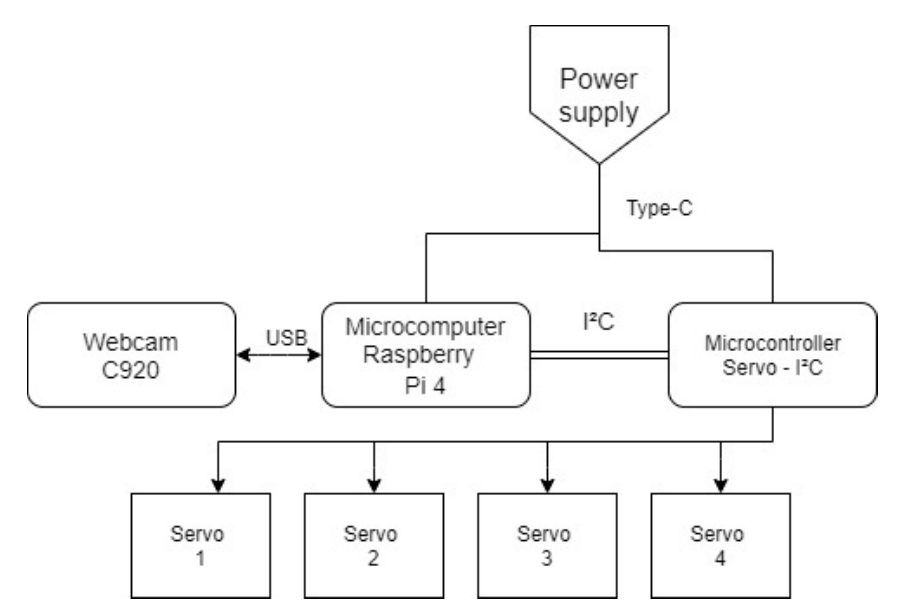
Figure 2. Block diagram of an automated sorting line for root, tuber and onion crops.